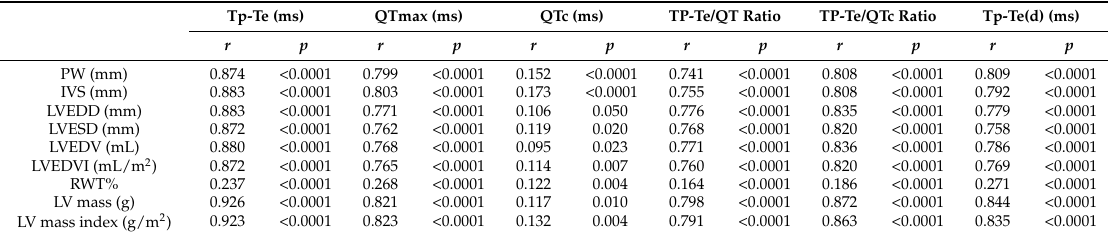
IVS: Interventricular septal thickness. LV mass: Left ventricular mass. LVEDD: Left ventricular end-diastolic diameter. PW: Posterior wall thickness.